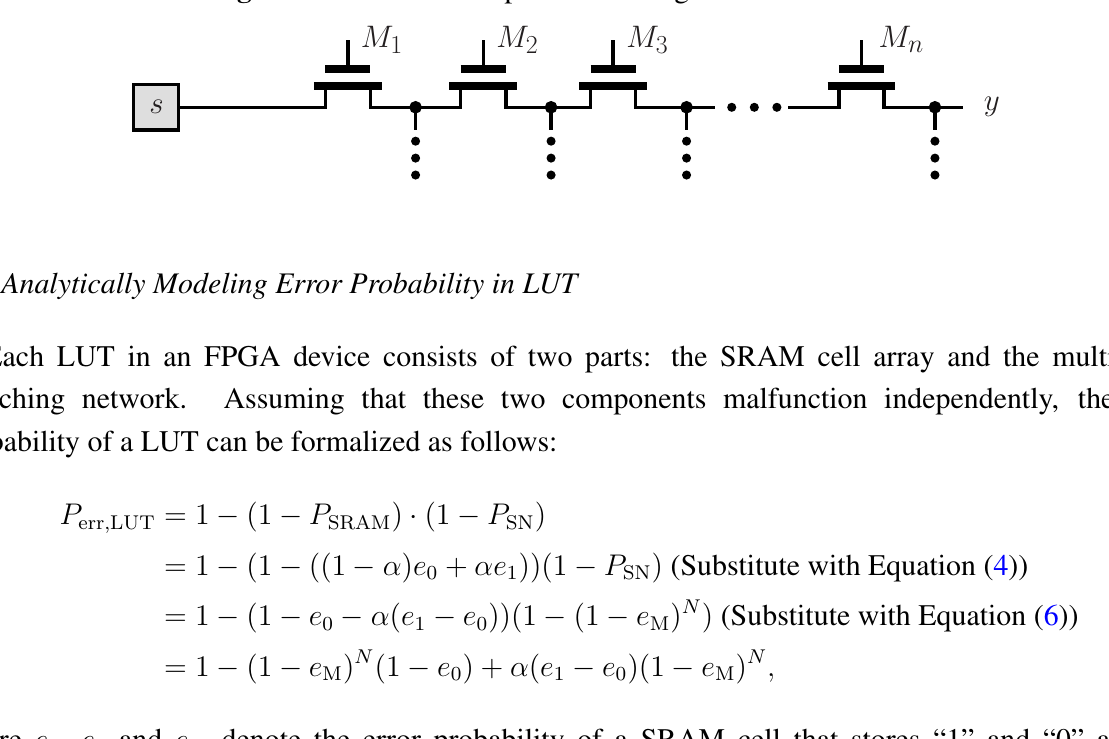
Figure 9. One switched path containing N